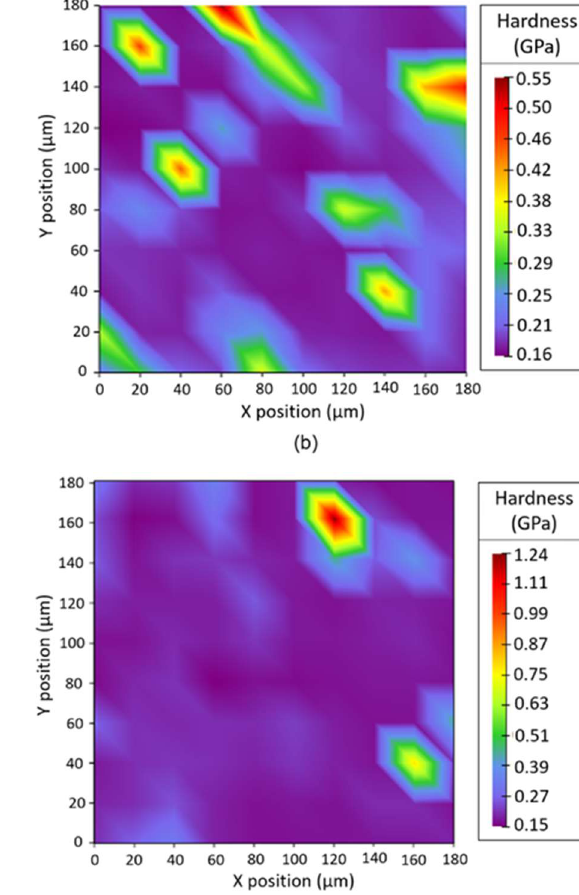
Figure 7. Hardness of CM samples as determined from nanoindentation test at different ( a ) carbon nanotube and ( b ) graphene contents in MCF/CNT and MCF/GNP composites, respectively. The relative ratio of MCF vs. CNT or GNP is reported in percentage by wt.